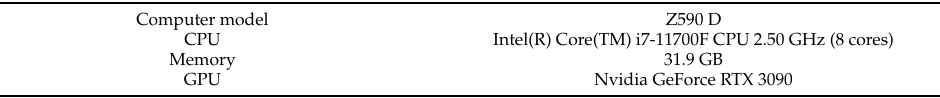
Table 2. Hardware configuration applied in